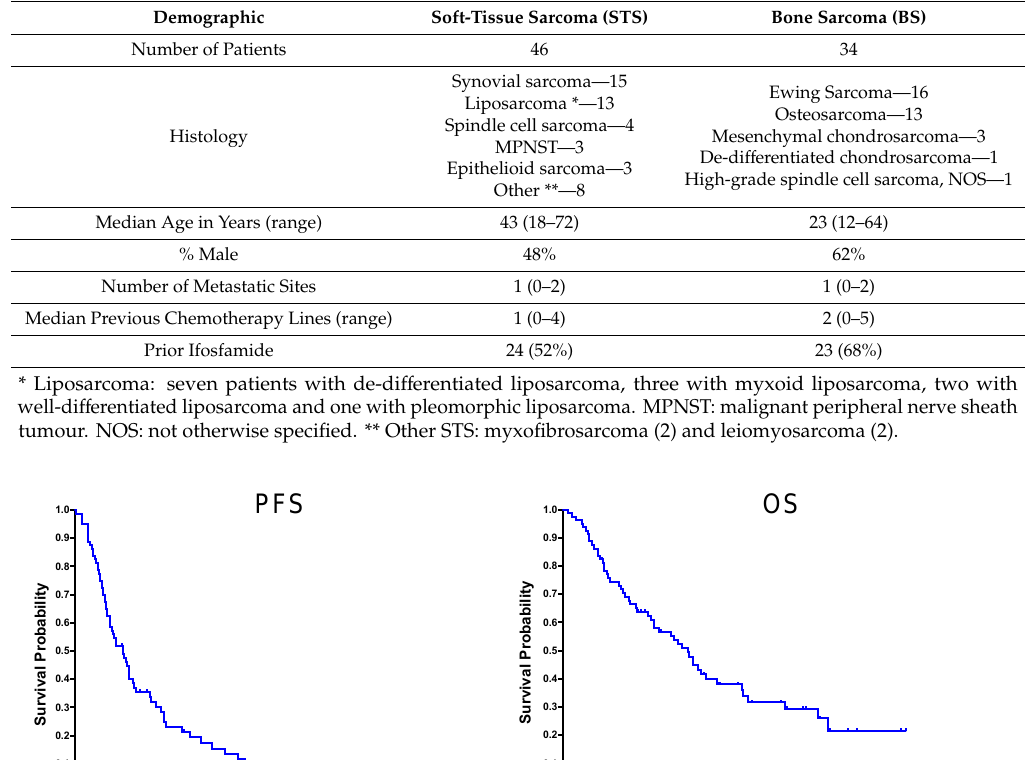
Table 1. Patient demographics, including histology for soft-tissue sarcoma (STS) and bone sarcoma (BS) cohorts.